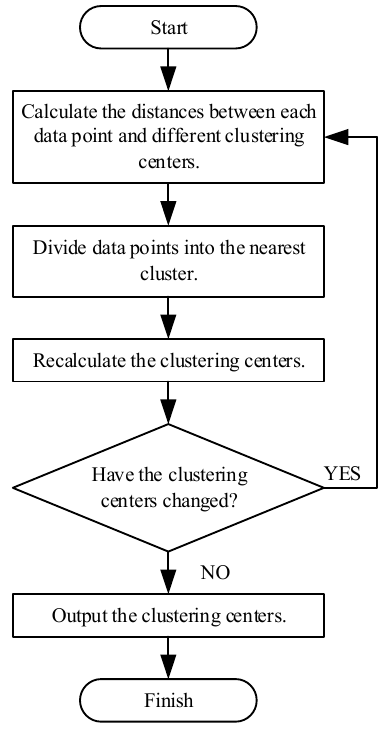
Figure 2. The clustering process.